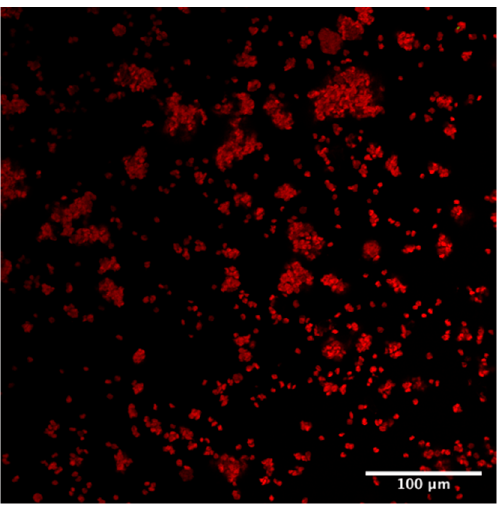
Figure 4. Laser Confocal Microscopy Image of unstained defibrillated cellulose 220 from native bi- omass.